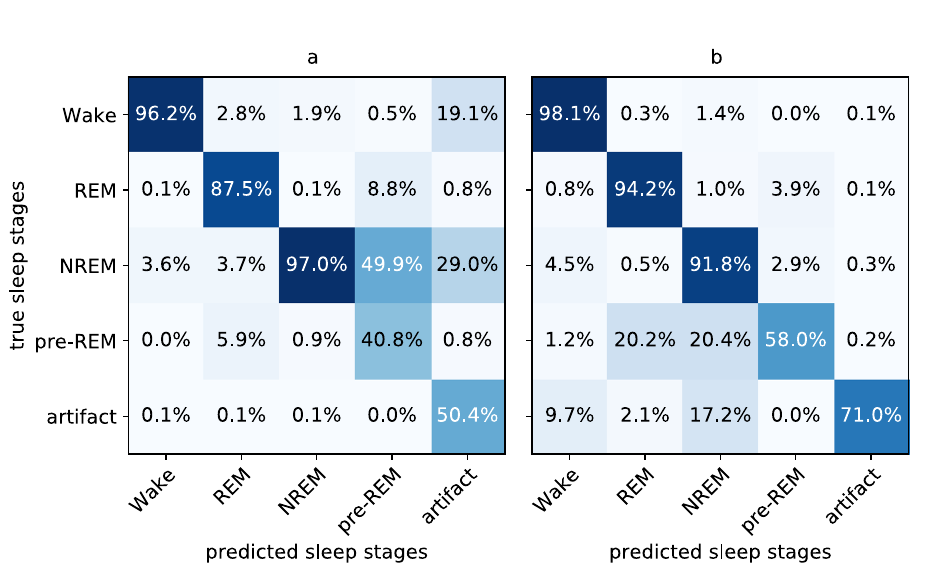
Figure 4. Confusion matrices of the best network evaluated on the test set (see Table 3): ( a ) Confusion matrix averaged by the predicted label frequency; diagonal elements correspond to precision. ( b ) Confusion matrix averaged by true label frequency; diagonal elements correspond to recall. A prediction of pre-REM is about 50% skewed towards NREM being the true stage, whereas a true pre-REM stage has equal probability to be mistaken for REM and NREM by the